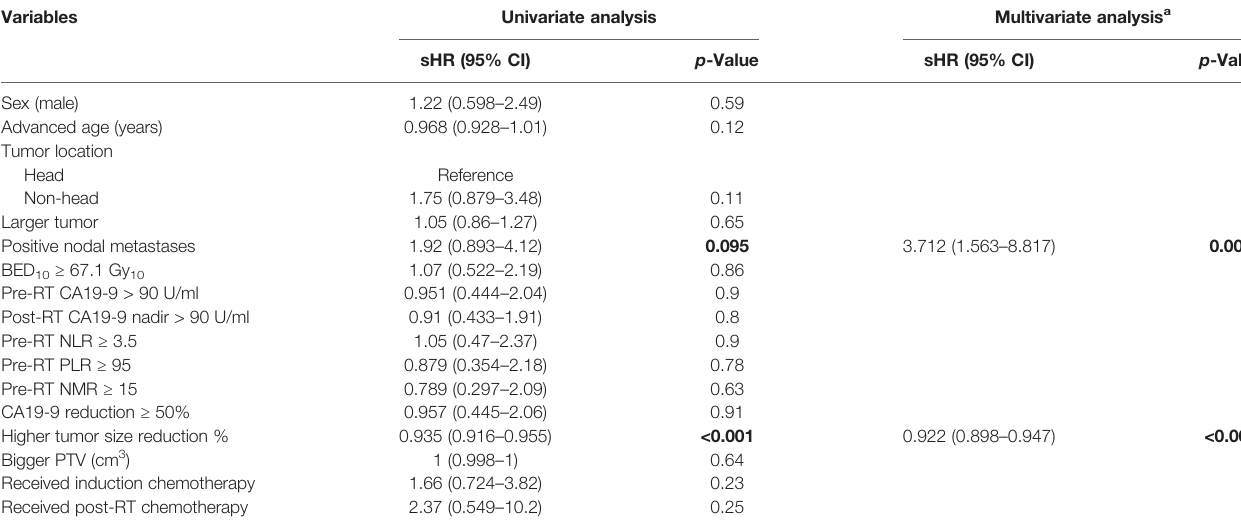
TABLE 3 | Univariate and multivariate analyses of factors associated with local progression in inoperable pancreatic adenocarcinoma (Fine – Gray model).